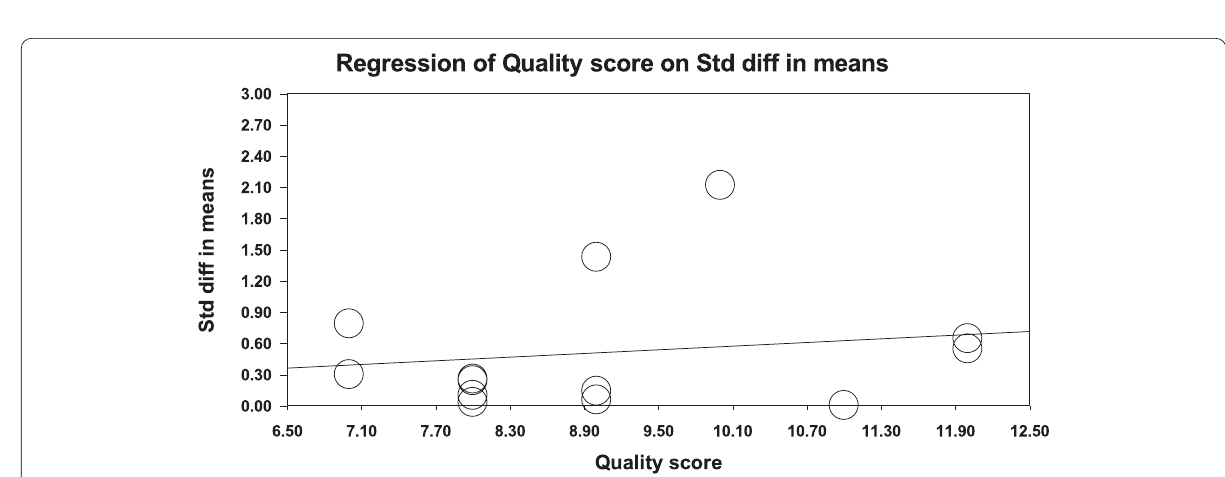
Fig. 9 The meta-regression of the relationship between the quality evaluation score of JBI checklist and SMD before and after intervention in the control and intervention groups